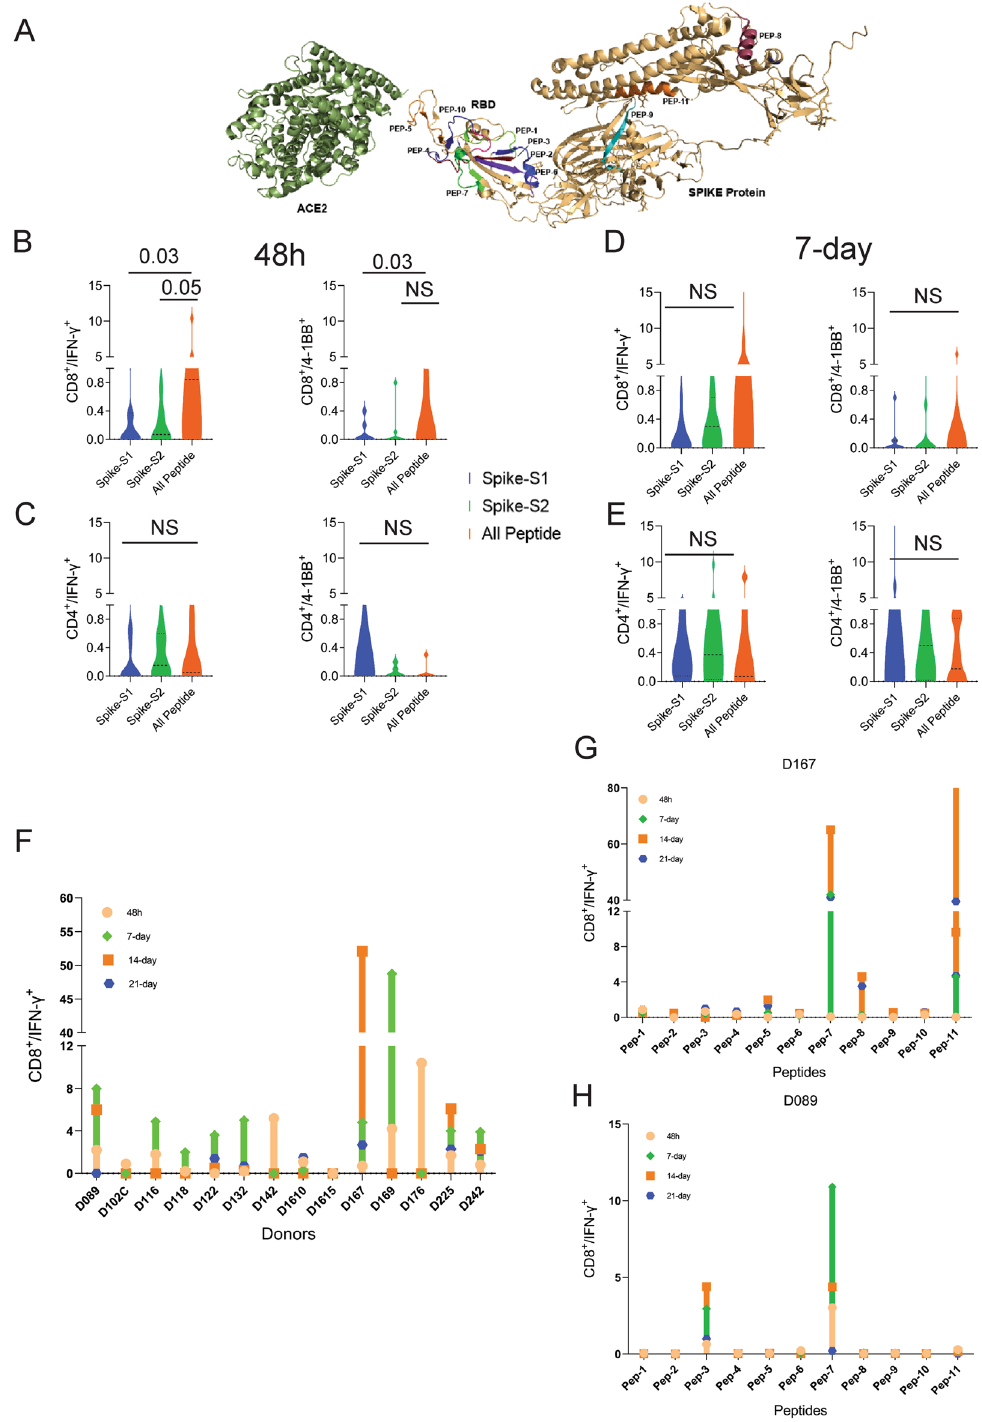
Figure 2. T-cell reactivity to SARS-CoV-2 Spike peptide pools and OncoPeptVAC prioritized peptides. Reactivity was determined by intracellular IFN-γ staining and surface expression of 4-1BB by FACS after stimulation of PBMCs from unexposed donors (n = 14) using separate pools of Spike-S1 and S2 peptides and the 11-Peptide-mix predicted by OncoPeptVAC (see “Methods”). ( A ) Structure of Spike—ACE2 receptor complex showing the location of the 11-peptides predicted by OncoPeptVAC. ( B-C ) T-cell activation after 48 h incubation with the peptides. ( D-E ) T-cell activation after a 7-day incubation with the peptides. ( F ) Kinetics and magnitude of CD8 T-cell activation in unexposed donor PBMCs. ( G,H ) CD8 T-cell response of donors D167 and D089 to individual peptides from the 11-peptide-mix. Statistical significance determined by Wilcoxon matched pairs signed rank test in Figures ( B - E